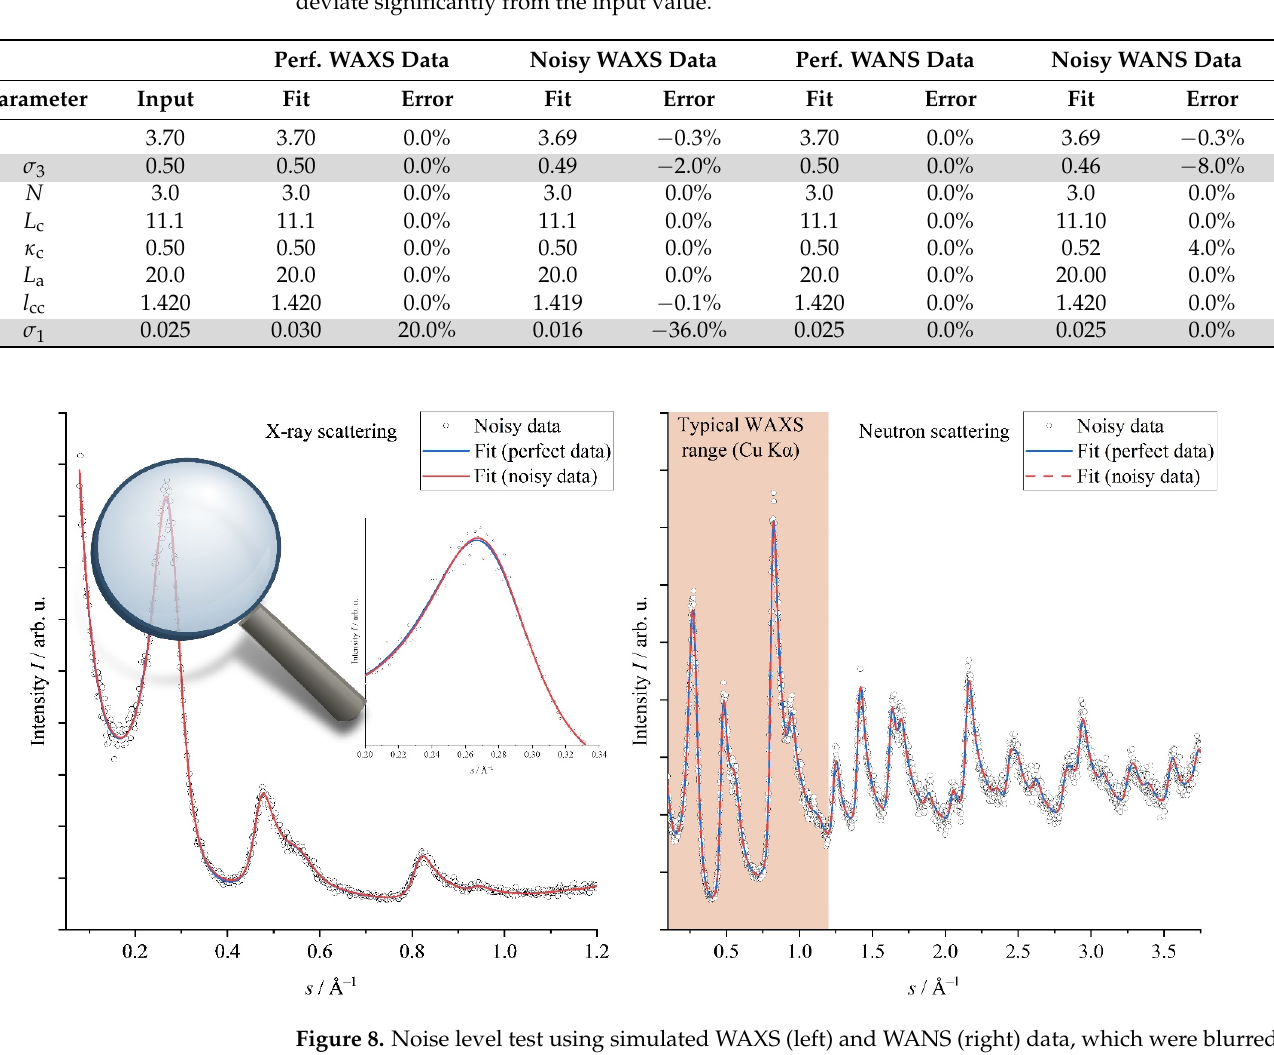
Table 4. Overview of the refinement of simulated WAXS data, which were blurred by statistical noise generated by a Gaussian distribution. The results indicate that OctCarb can evaluate reproducibly microstructural parameters from given WAXS and WANS data. Since the influence of σ 1 on WAXS (for typical Cu-K α lab setups) and the influence of σ 3 on WANS data is only small, these parameters cannot always be determined exactly. Therefore, the resulting values for σ 1 (WAXS) and σ 3 (WANS) deviate significantly from the input value.